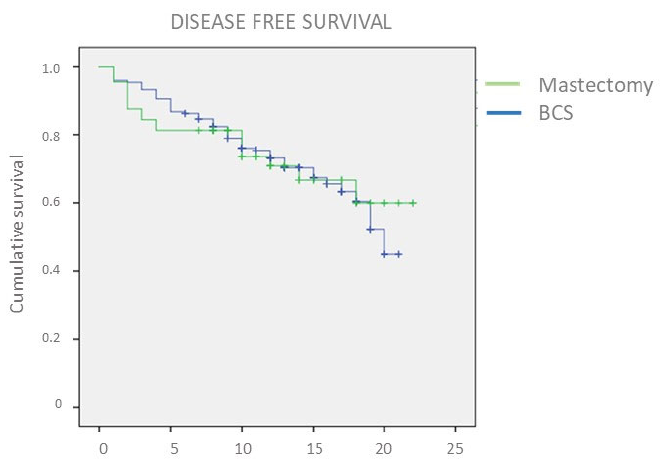
Figure 1. Disease-free survival curve according to type of surgical treatment received. Figure 1. Disease ‐ free survival curve according to type of surgical treatment received.